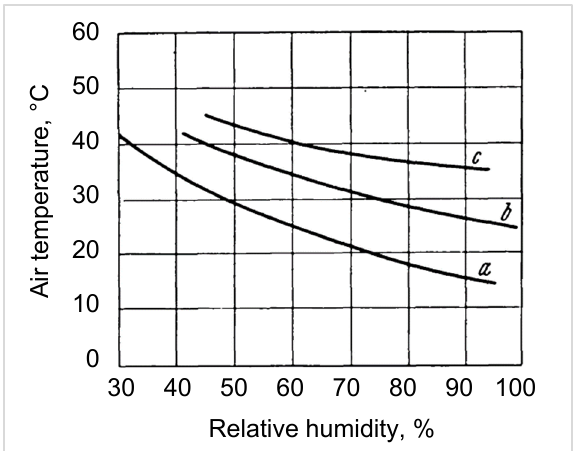
Figure 1. The limit values: ( a ) sultriness curve acc. Lancaster-Castens, ( b ) decrease in performance during heavy physical work acc. Ehris-Mann-Hasse, ( c ) limit of endurance acc. Wezler-Thauer [30]. The curve defines the boundary of sultriness with respect to temperature (T in ◦ C) and relative humidity (RH in %). What is interesting, it indicates that the sultriness does not occur at temperatures below 16.5 ◦ C even if the relative humidity reaches 100% [30].